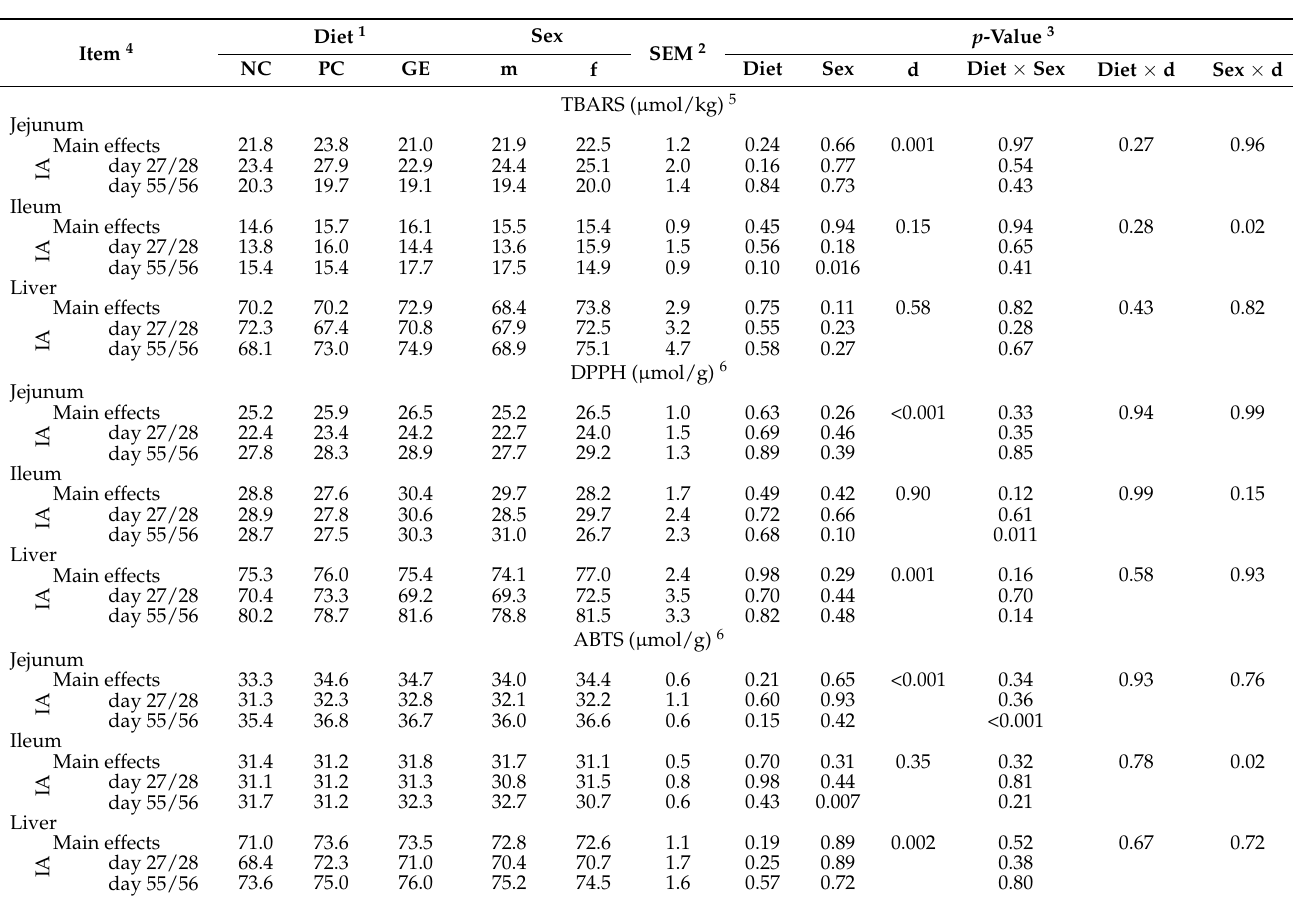
Table 6. Effect of dietary GE supplementation on lipid peroxidation (measured by thiobarbituric acid reactive substances (TBARS)) and antioxidant capacity (measured by 2,2-diphenyl-1-picrylhydrazyl (DPPH) and 2,2-azinobis (3-ethilenzotiazolin)-6sulfonate (ABTS)) from the intestinal tissue and liver of the weaning piglets compared to NC and